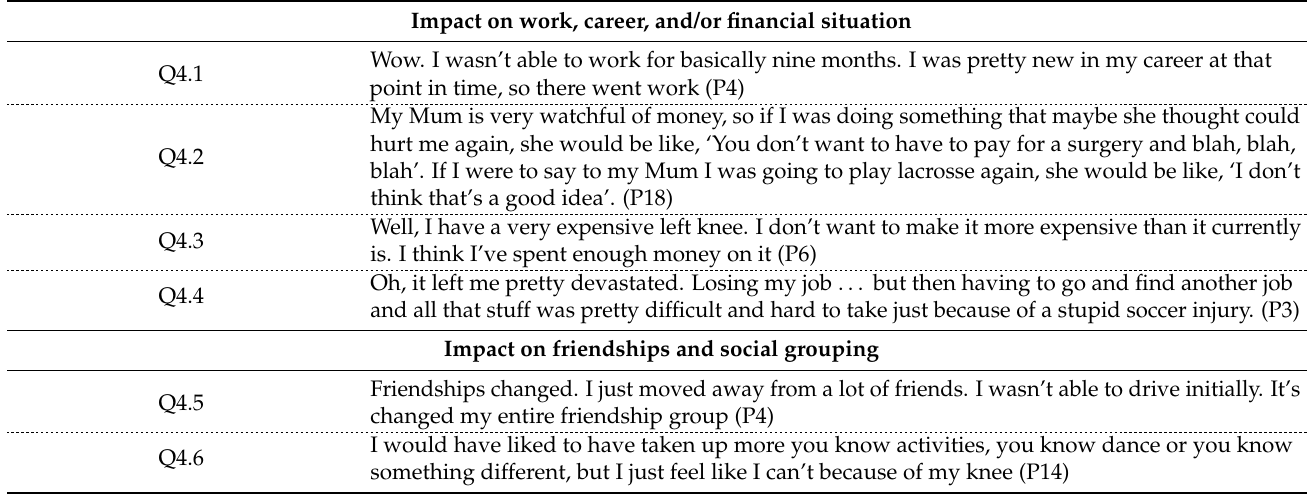
Table 5. Supporting Quotes to theme 4—socio-economic factors driving